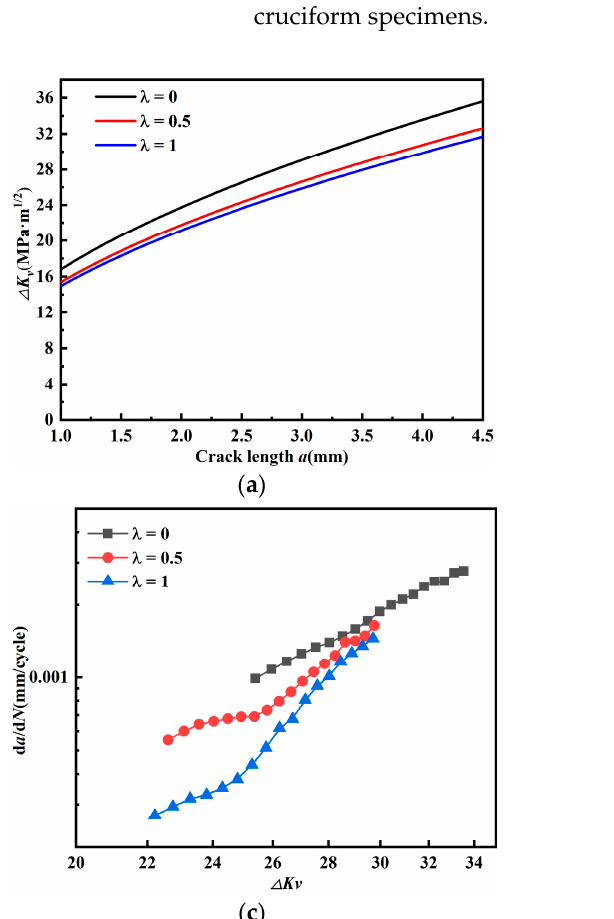
Figure 16. Pook model. ( a ) Relationship between a and △ K R ( β = 45°). ( b ) Relationship between a and △ K R ( β = 45°).